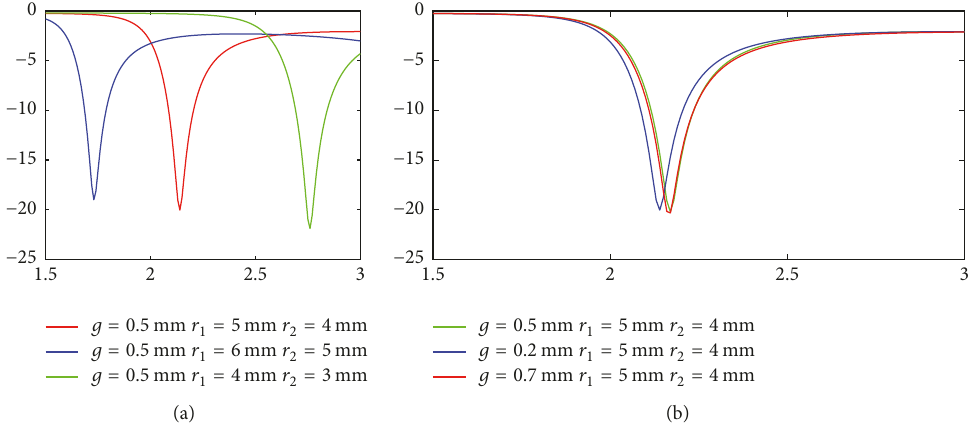
Figure 3: (a) Parametric simulation of change in inner and outer radii 𝑟 1 and 𝑟 2 . (b) Parametric simulation of change in the gap 𝑔 .